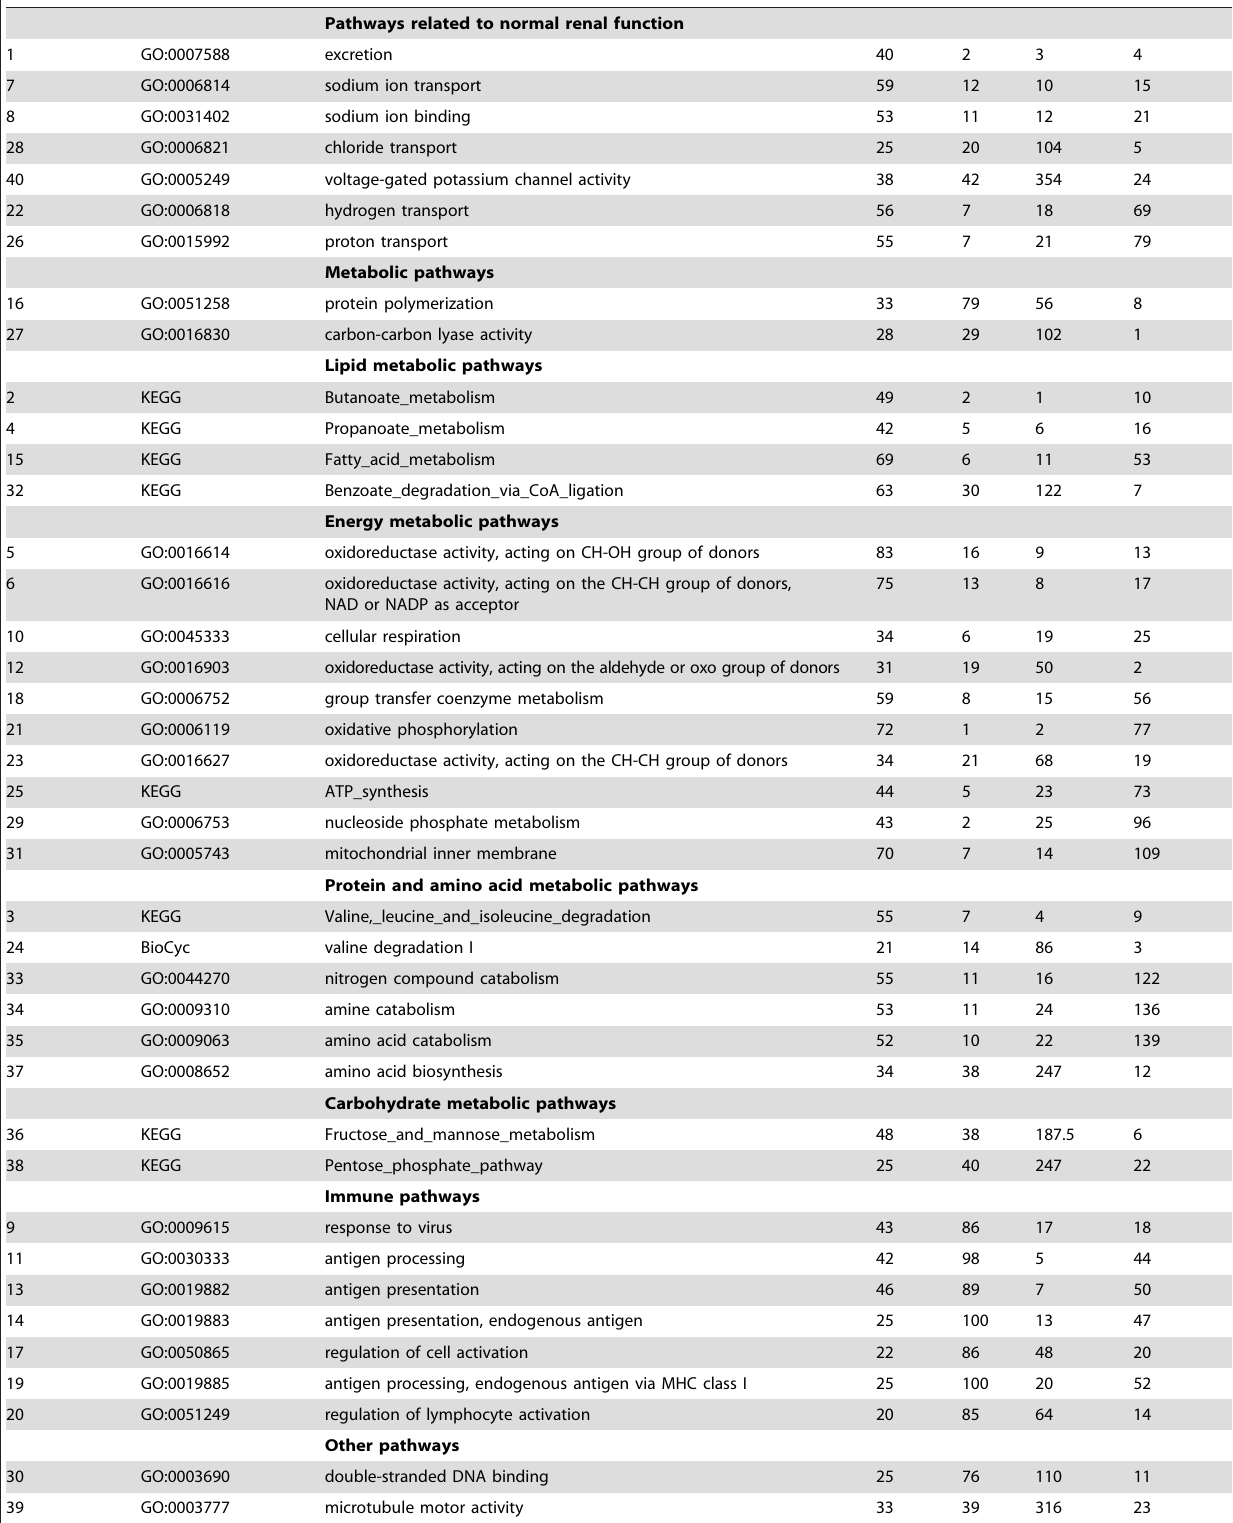
Table 1. Pathway signature of clear cell renal cell